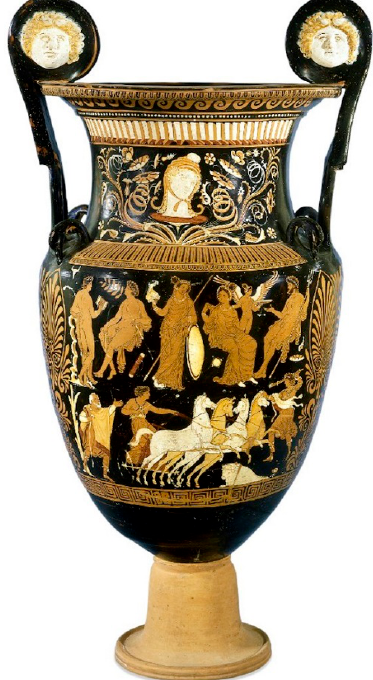
Figure 13. London, British Museum F 279 Apulian volute-krater, Darius Painter, ca. 340–320 B.C. Head wearing Phrygian cap rising from red flower in floral surround (neck) and the death of Hippolytos (body). Photograph © The Trustees of the British Museum.